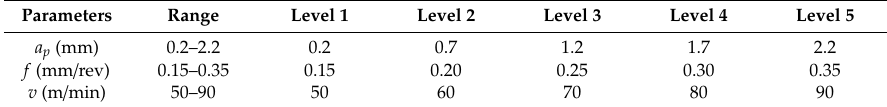
Table 3. Cutting parameters and their levels.